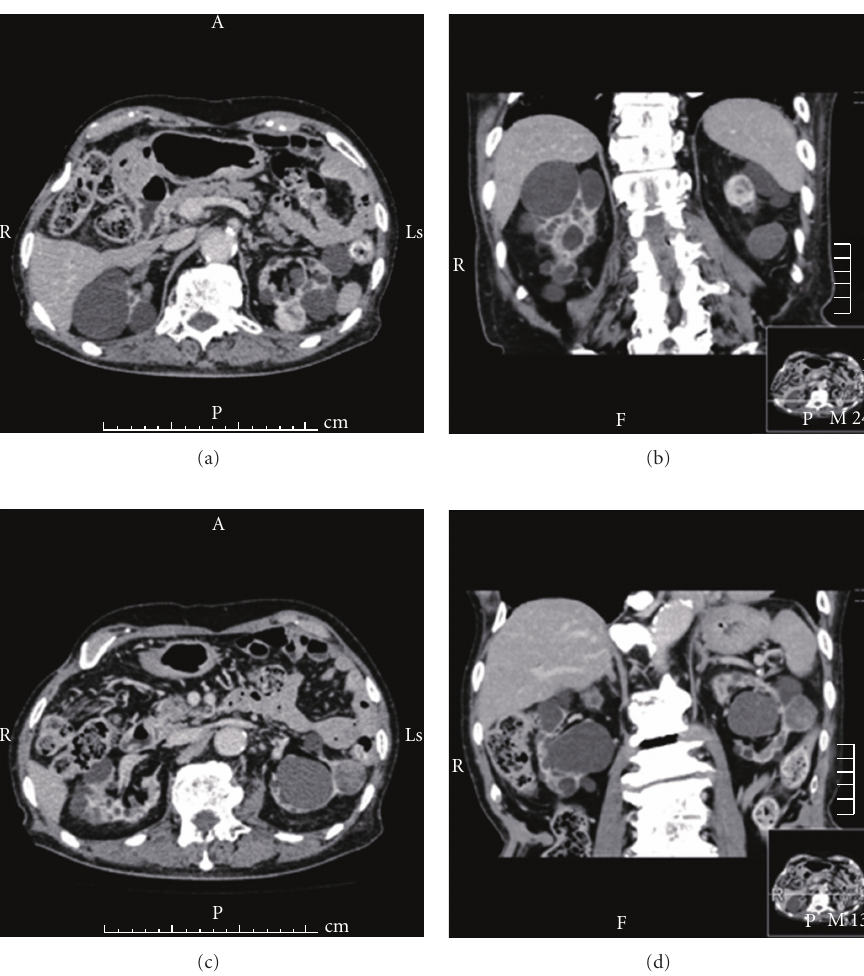
Figure 1: Abdominal computed tomography demonstrated two masses, 2 . 1 × 2 . 0cm and 2 . 4 × 2 . 2cm in diameter, at the middle of the left kidney with acquired cystic disease of the